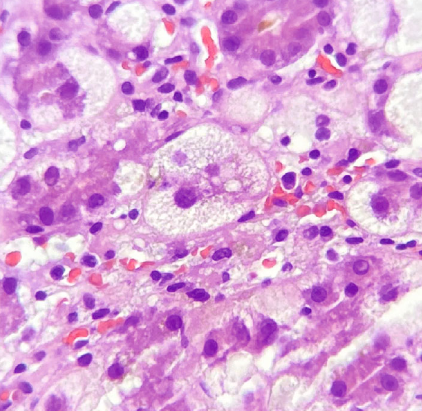
abundant and clear cytoplasm (400x, H&E staining). Source: own .